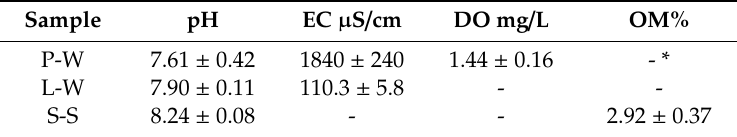
Table 1. Water quality of P-W and L-W and soil basic properties a